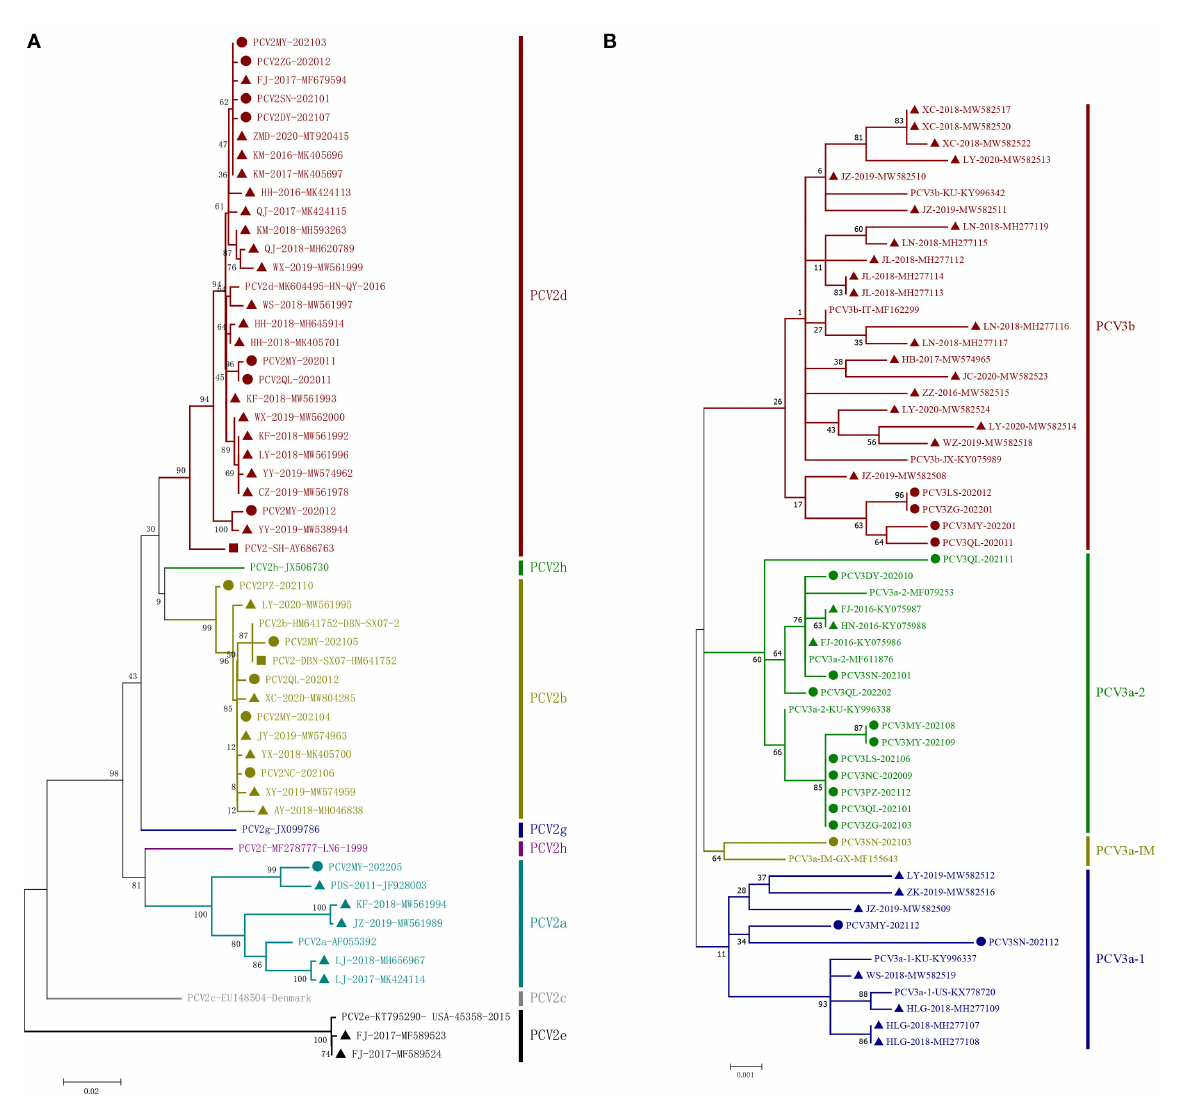
FIGURE2 Phylogenetic trees based on the ORF2 gene of PCV2 and the complete coding sequences (ORF1 + ORF2) of PCV3. The ML tree was constructed with a p-distance model and bootstrapping at 1,000 replicates. (A) : PCV2. (B) : PCV3. The PCV3 subtypes were proposed by Li et al. (28). The strains sequenced in this study are marked with circles; the Chinese reference sequences are marked with triangle; the vaccine strains are marked with square. The different genotypes are represented by different colors as indicated in the figures.